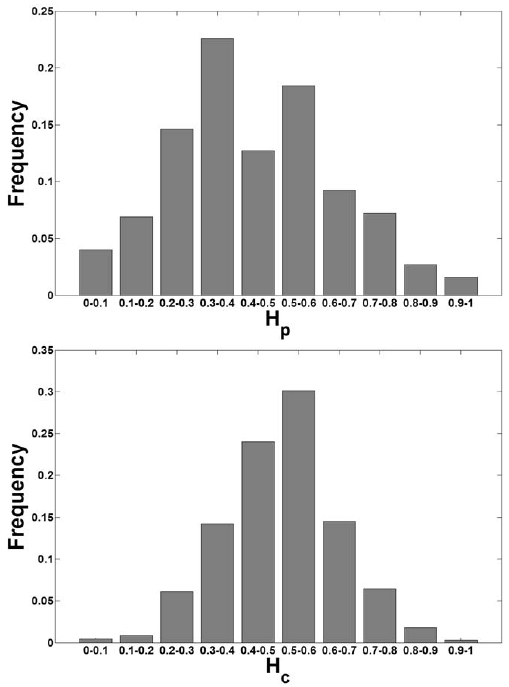
Fig. 5. Histograms of the shape hydrograph variables. (a) H p ; (b) H c